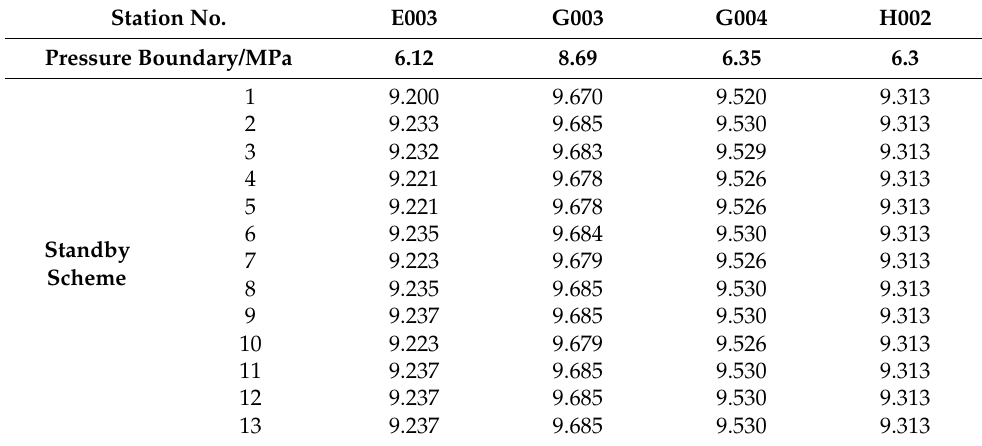
Table 8. Pressures of the take points in different schemes. Station